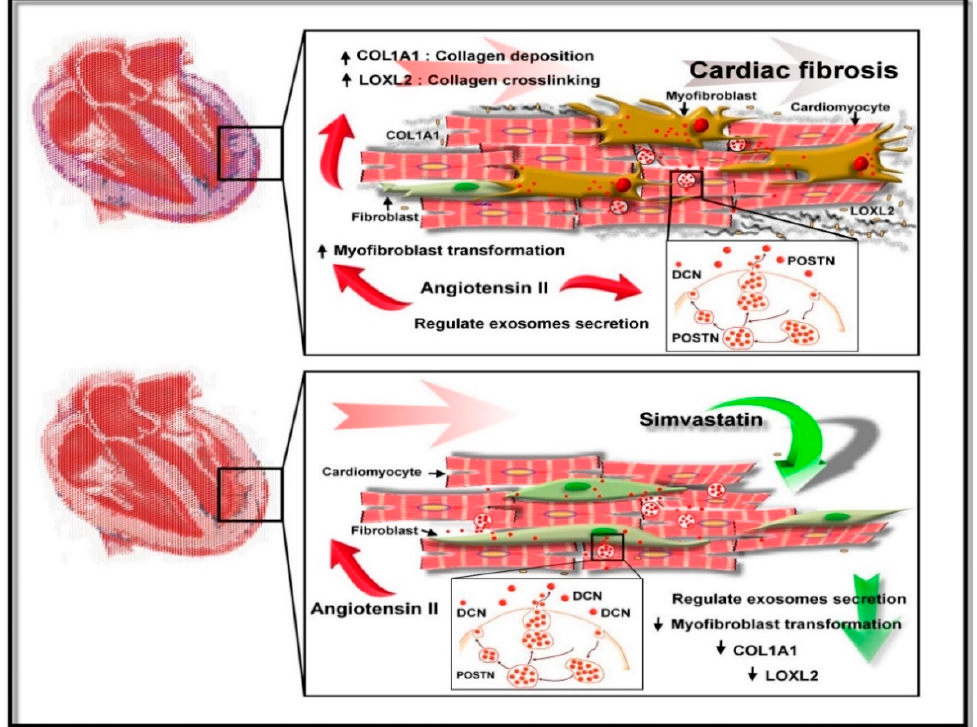
Figure 8. Suggested mechanism underlying Simvastatin-induced suppression of Ang II-mediated fibroblast. SIMmightsuppressfibroblasttomyofibroblasttransformation,collagenproduction / deposition,andincreased fibroblast motility by inducing cardiomyocyte secretion of exosomal